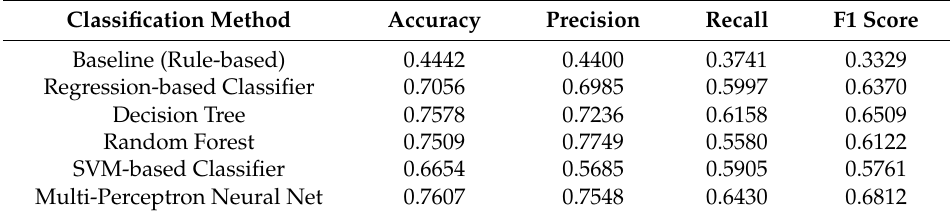
Table 3. Classification results for emergency degrees of ER